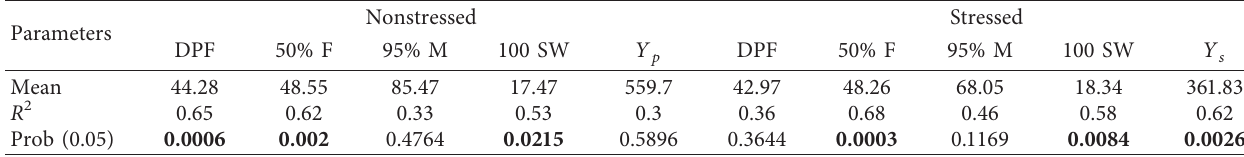
Table 2: Results of analysis of variance of parameters measured under nonstressed and stressed conditions. Parameters